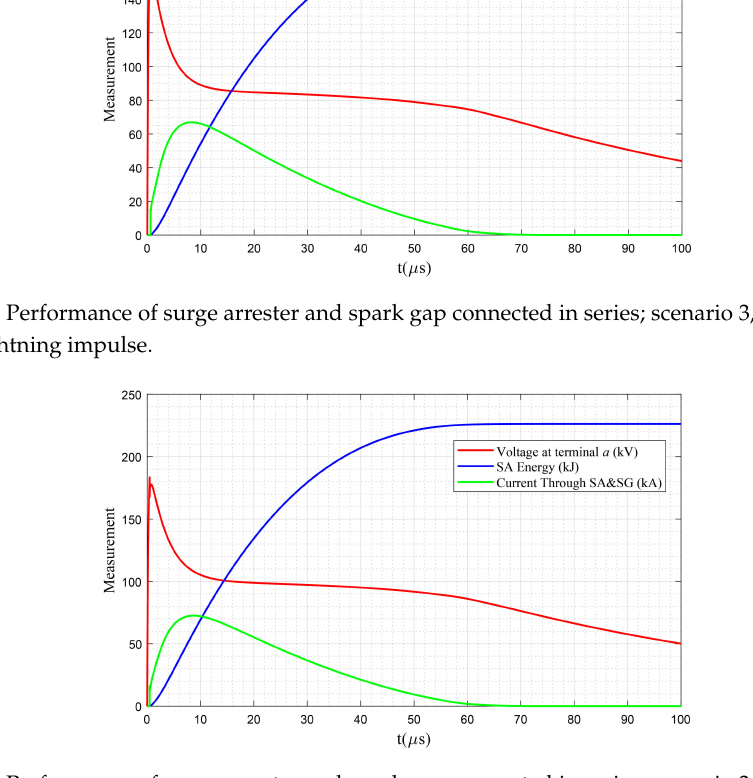
Figure 23. Performance of surge arrester and spark gap connected in series; scenario 3, SA-42b under 200 kV lightning